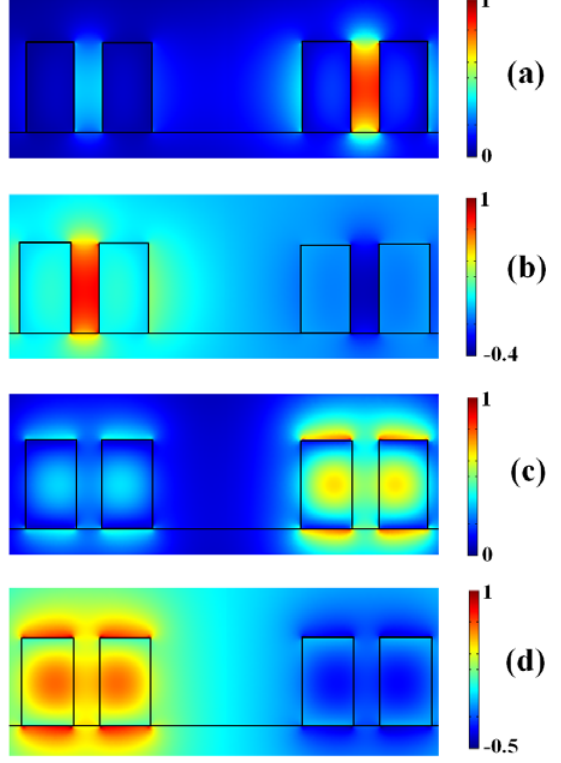
Figure 4 . Main electric field component distribution related to supermodes supported by the asymmetrical directional coupler ( d = 1 µm). (a) Quasi-TE symmetric supermode. (b) Quasi-TE antisymmetric supermode. (c) Quasi-TM symmetric supermode. (d) Quasi-TM antisymmetric supermode.